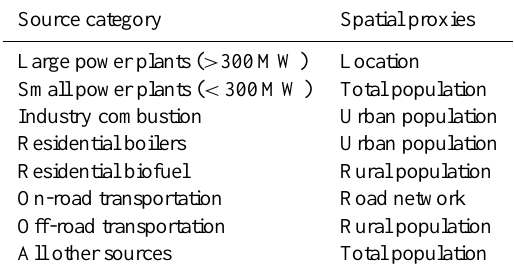
Table 4 listed the spatial proxies used in this work.